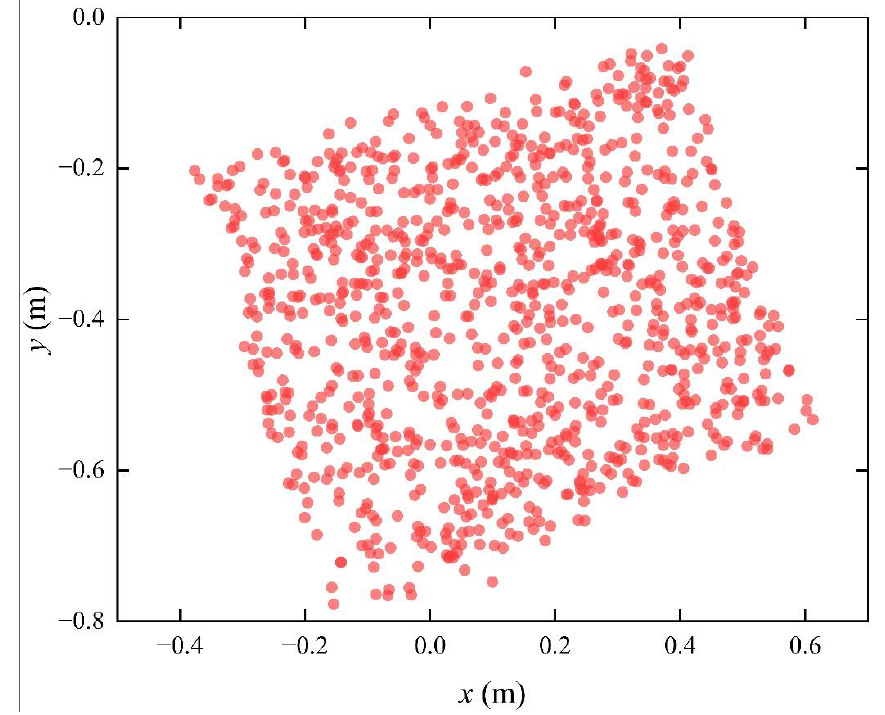
Figure 6. Interception points of Monte Carlo simulation under Case 3.